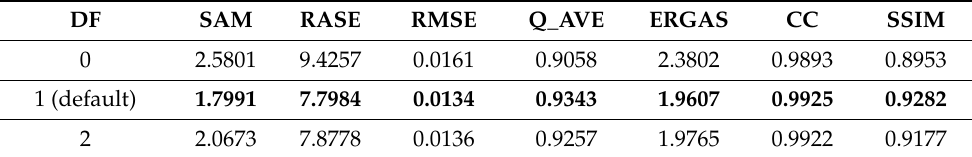
Table 9. Quantitative assessment results of feature enhancement module. The best performance is shown in bold.